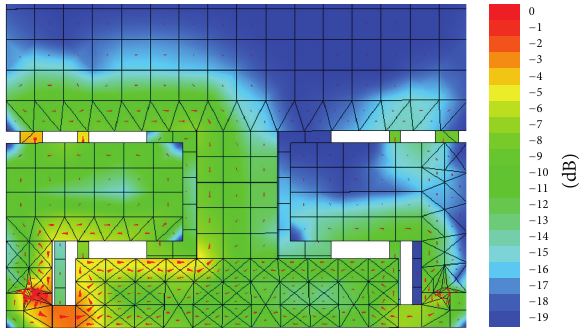
Figure 8: Back view of the antenna. Surface current distributions without the T-shaped slot at 780 MHz when Port 1 is